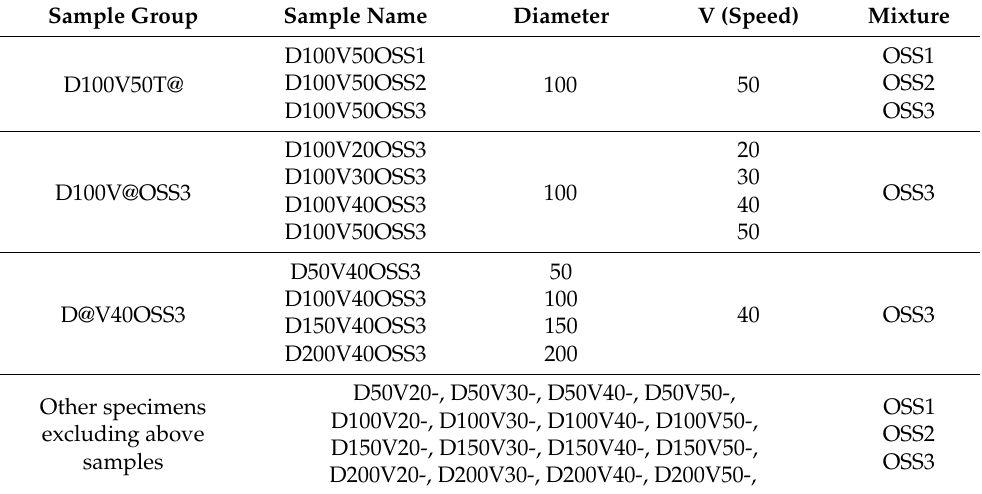
Table 3. The cylinder samples for the BI